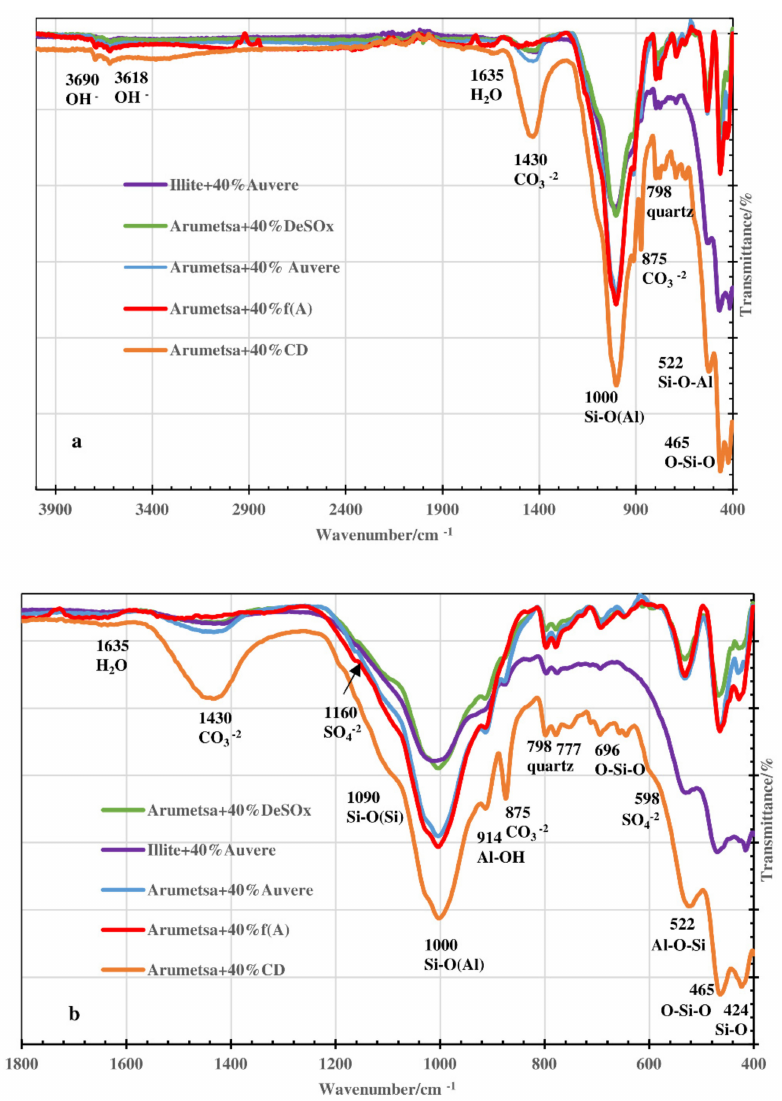
Figure 7. FTIR spectra of initial blends based on Arumetsa and illitic clay with 40% of different additives. ( a ) Wavenumber range of 4000–400 cm − 1 . ( b ) Wavenumber range of 1800–400 cm − 1